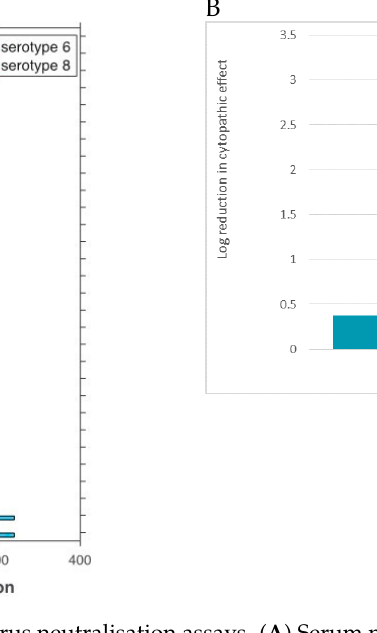
Figure 2. Virus neutralisation assays. ( A ) Serum neutralisation test results using EHDV serotype 6 (cyan) and serotype 8 (purple) reference isolates. ( B ) Values represent the log reduction in cytopathic effects (neutralisation).